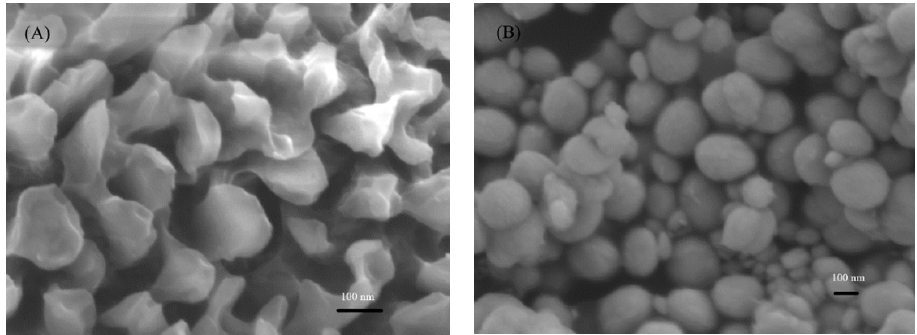
Figure 8. SEM images of ( A ) 0.01BiOCl/MnMgAl-HT and ( B ) 0.01BiOCl/MnMgAlO .